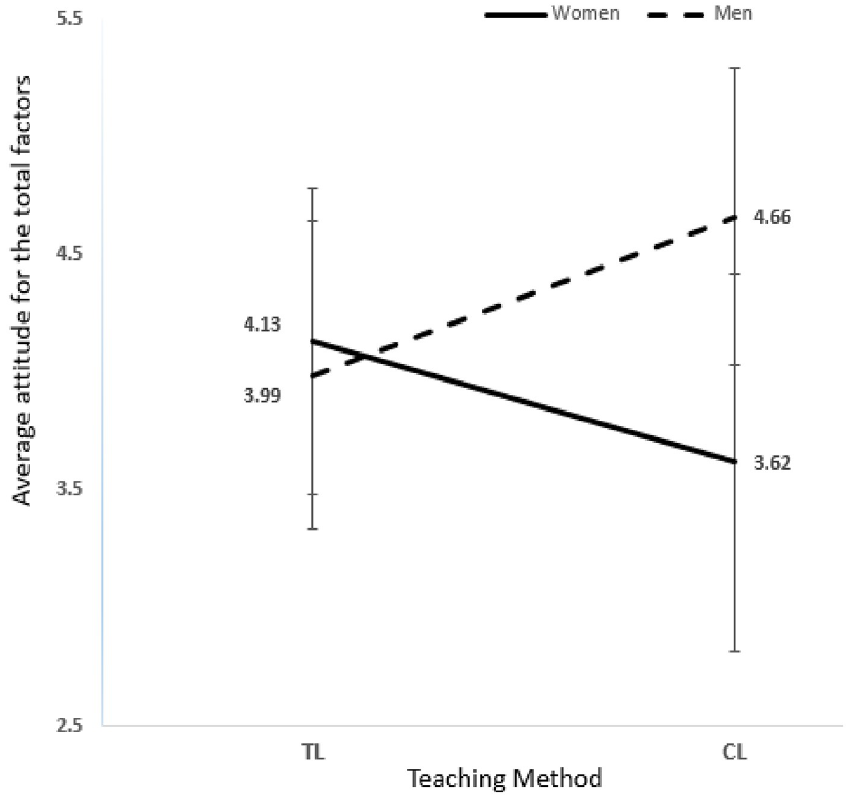
Fig 8. Major mix-gender: Present the total nine attitude factors mean and SD for major mix-gender students.